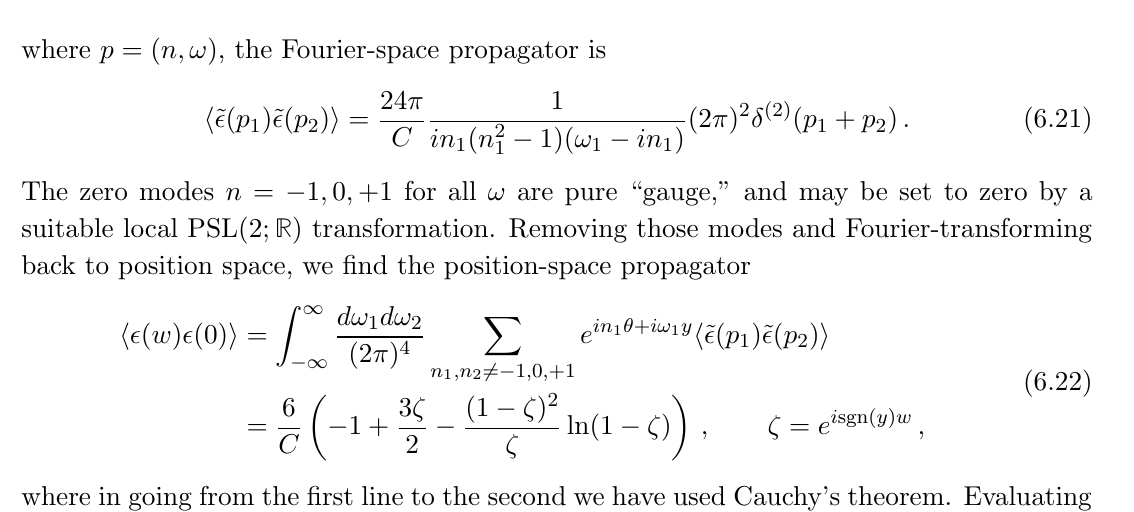
Figure 3 . The diagram with n exchanges of the (cid:15) (cid:12)eld between two